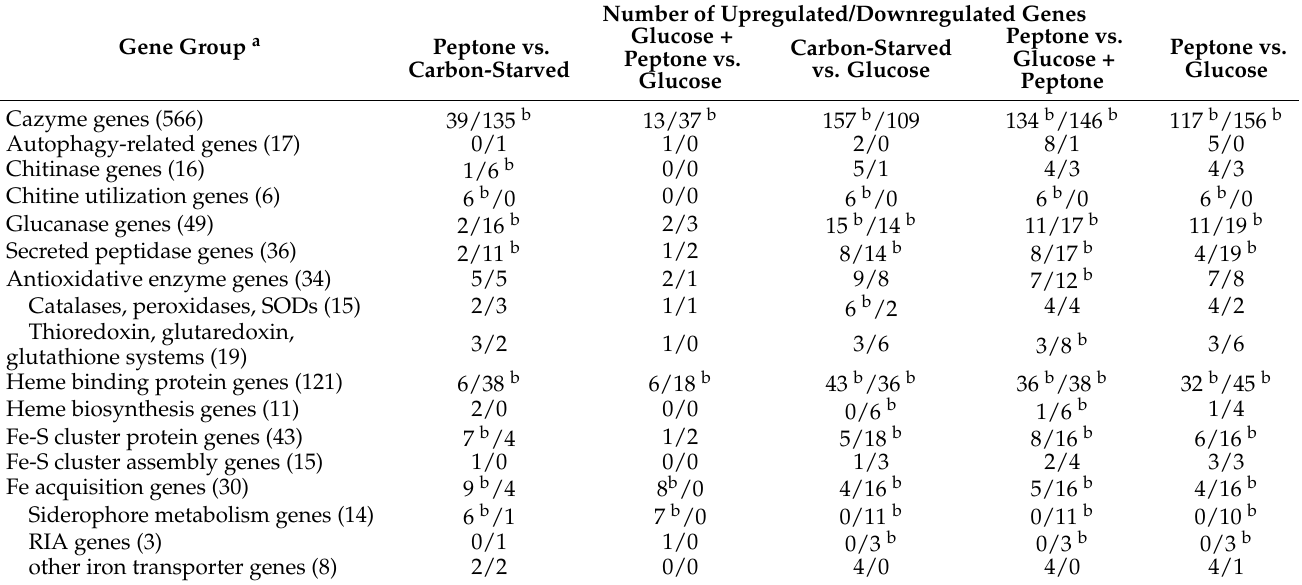
Table 3. Transcriptional behavior of selected gene groups in carbon-stressed A. fumigatus cultures. Number of Upregulated/Downregulated Genes Peptone vs. Glucose + Gene Group a Peptone vs. Peptone vs. Carbon-Starved Glucose + Peptone vs. Carbon-Starved vs. Glucose Peptone Glucose